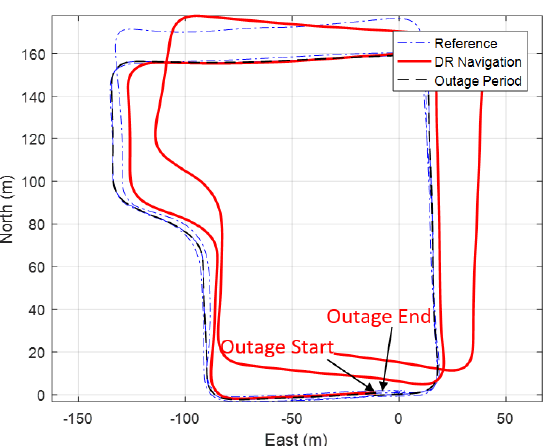
Figure 15. DR trajectory based on CPD sensors and onboard gyroscope for 180 seconds GNSS signal outage